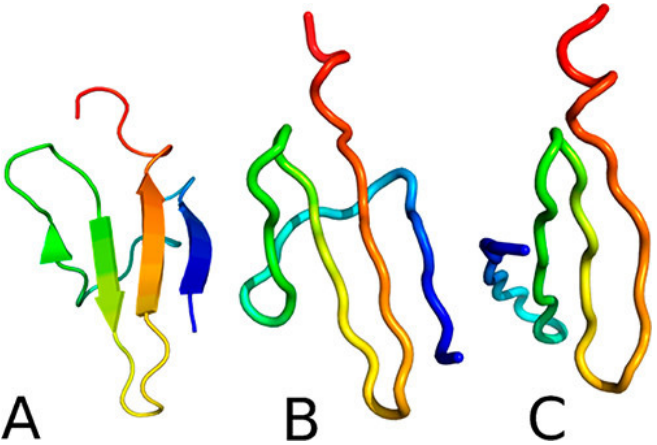
Figure 5. Experimental structure of pT37pT46 4E-BP2 18 − 62 ( A ) compared with the most similar struc- tures obtained after simulations and clustering of pT37pT46 4E-BP2 18 − 62 ( B ) and WT 4E-BP2 18 − 62 ( C ). Reproduced with permission from A.K. Sieradzan et al., J. Chem. Theory Comput. 17, 3203–3220 (2021). Copyright 2021 American Chemical Society.